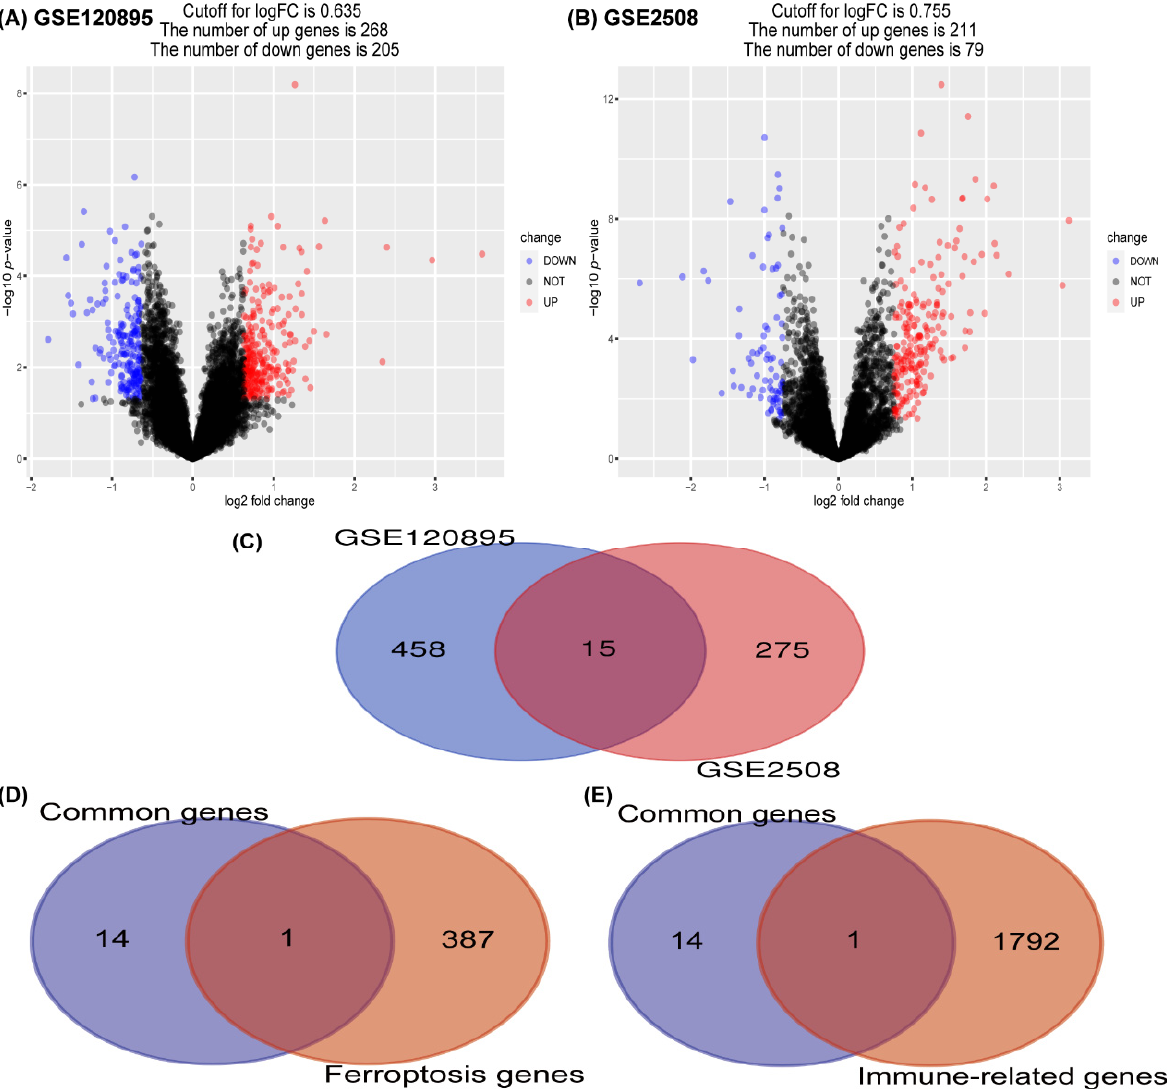
Figure 1. Identification of common genes in GSE120895 and GSE2508. ( A ) The volcano plot shows differentially expressed genes (DEGs) in GSE120895. Red indicates up-regulated genes, and blue indicates down-regulated genes. ( B ) The volcano plot shows DEGs in GSE2508. ( C ) Venn diagram of DEGs in two datasets. ( D ) Venn diagram of common genes and ferroptosis genes. ( E ) Venn diagram of common genes and immune-related genes.